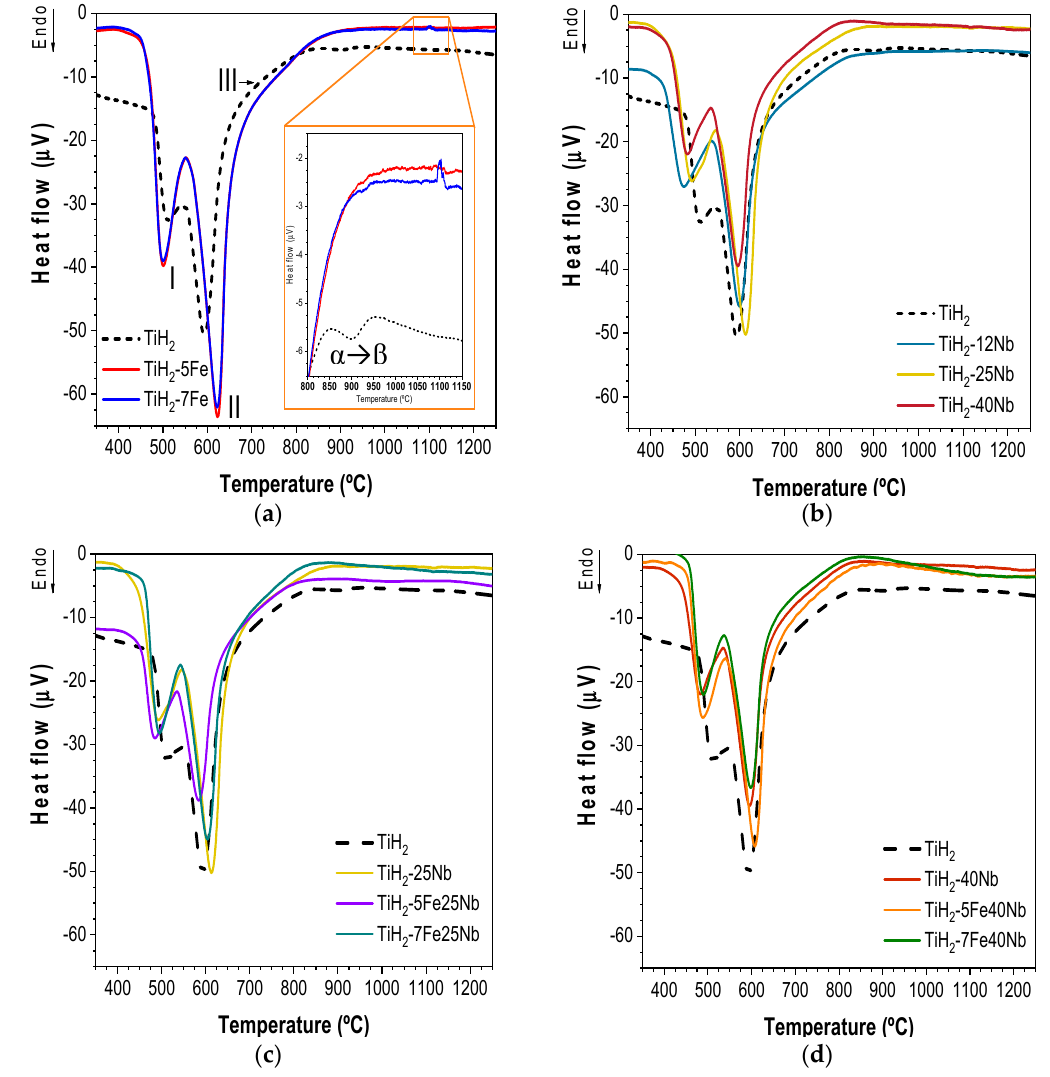
Figure 2. Comparison of differential thermal analysis (DTA) curves between TiH 2 and mixtures of powders under high purity argon atmosphere heated at 10 °C/min. ( a ) TiH 2 -Fe (5 and 7 wt. %); ( b ) TiH 2 -Nb (12, 25, 40 wt. %); ( c ) TiH 2 -Nb-Fe (25 wt. % Nb and 5, 7 wt. % Fe) and ( d ) TiH 2 -Nb-Fe (40 wt. % Nb and 5, 7 wt. % Fe).